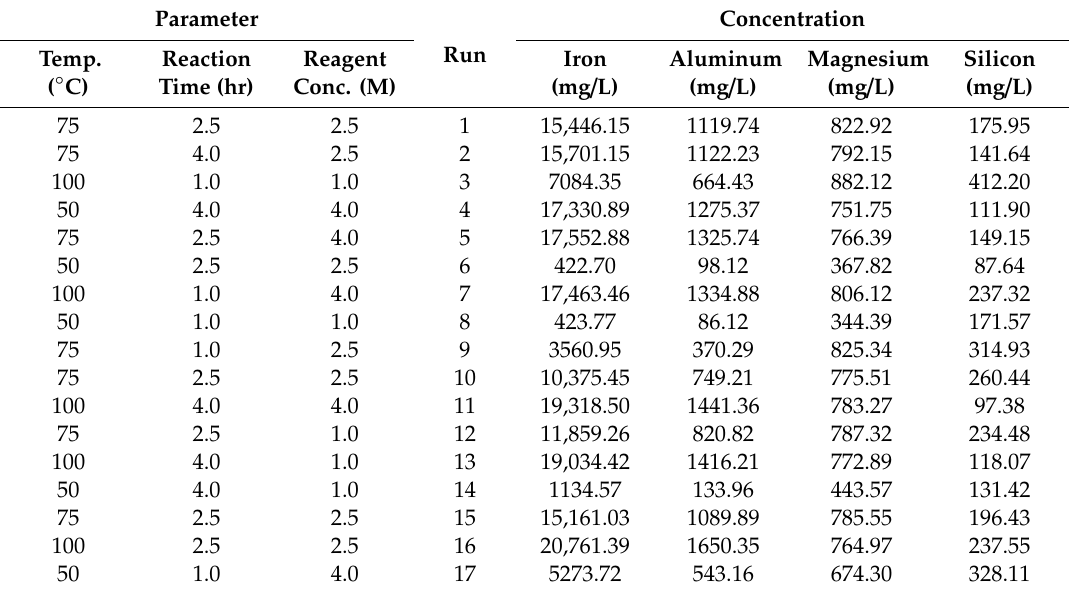
Table A1. Aluminum, iron, magnesium, and silicon concentrations from RSM-designed experiment.